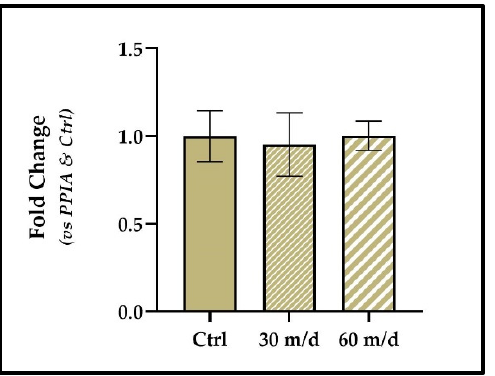
Figure 6. Gene expression of YWHAZ in primary human bone marrow-derived MSCs stimulated for 30 and 60 min per day versus PPIA and the unstimulated control. N = 3 for all groups.